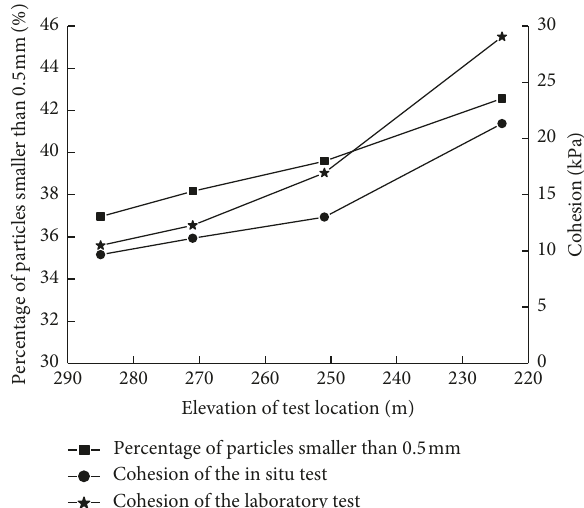
Figure 12: Grading curves of undisturbed soil samples.